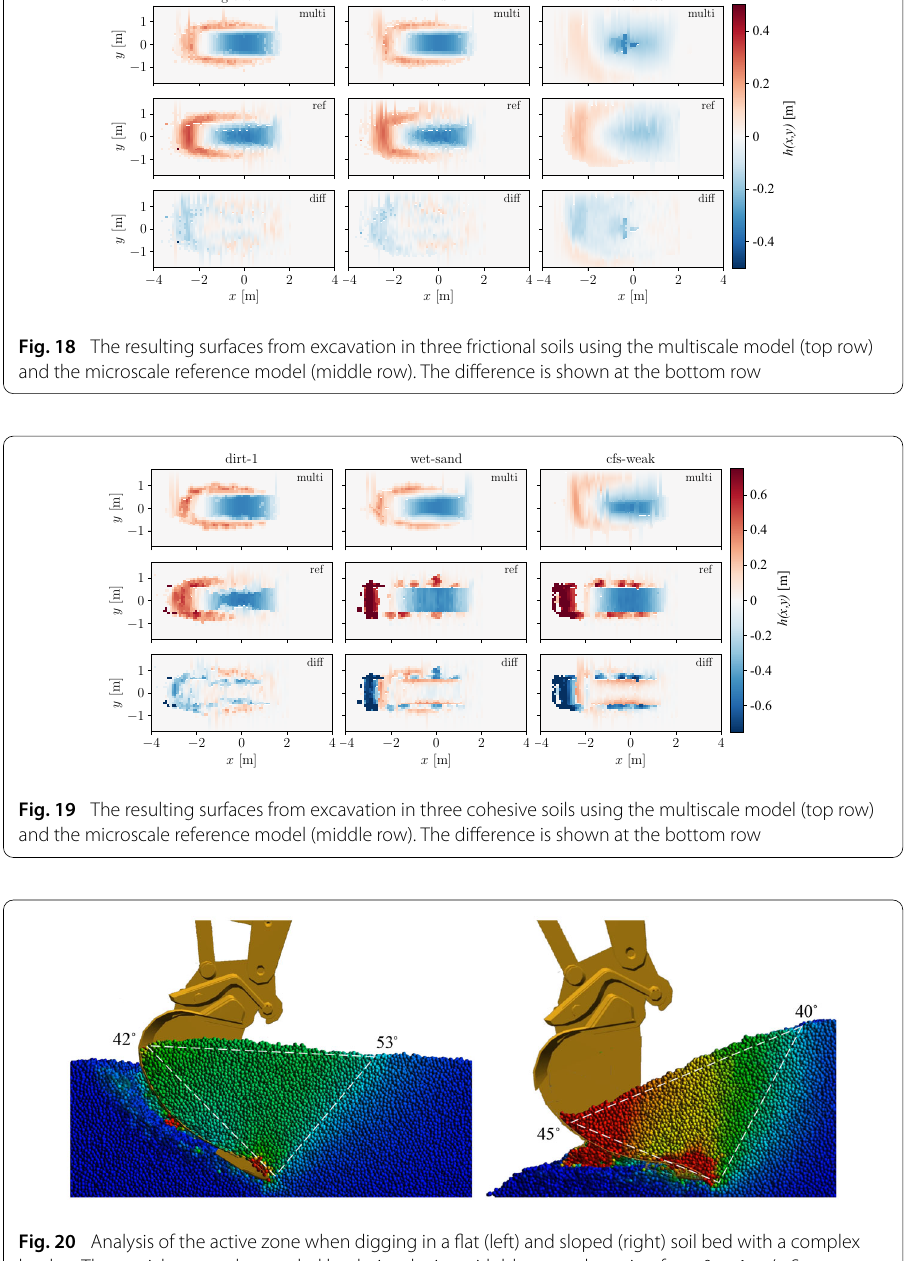
Fig. 20 Analysis of the active zone when digging in a flat (left) and sloped (right) soil bed with a complex bucket. The particles are colour coded by their velocity, with blue to red ranging from 0 to 1 m/s. See Additional file 5: Video